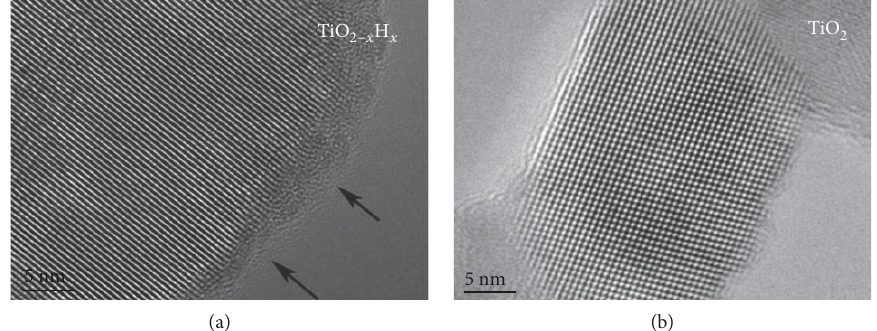
Figure 2: HRTEM images of (a) black hydrogenated TiO (2013)